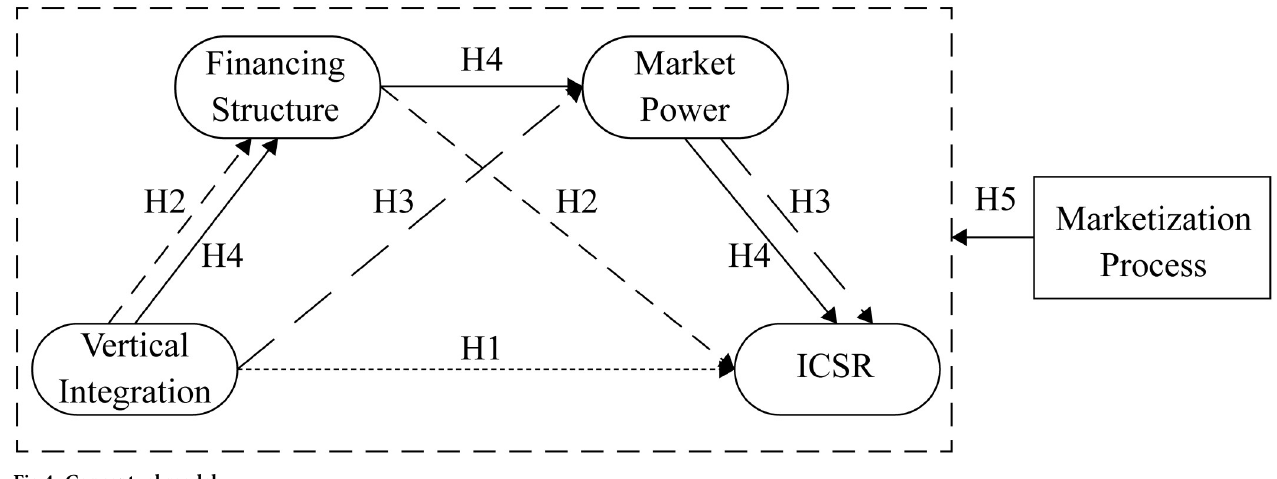
Fig 4. Conceptual